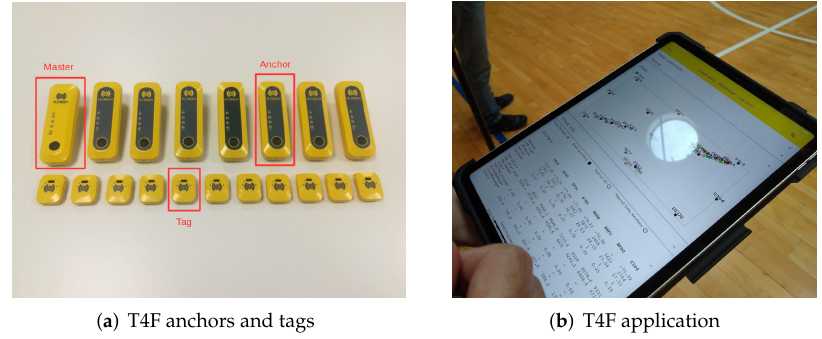
Figure 6. ( a ) T4F UWB modules (anchors and tags). ( b ) T4F application running on a